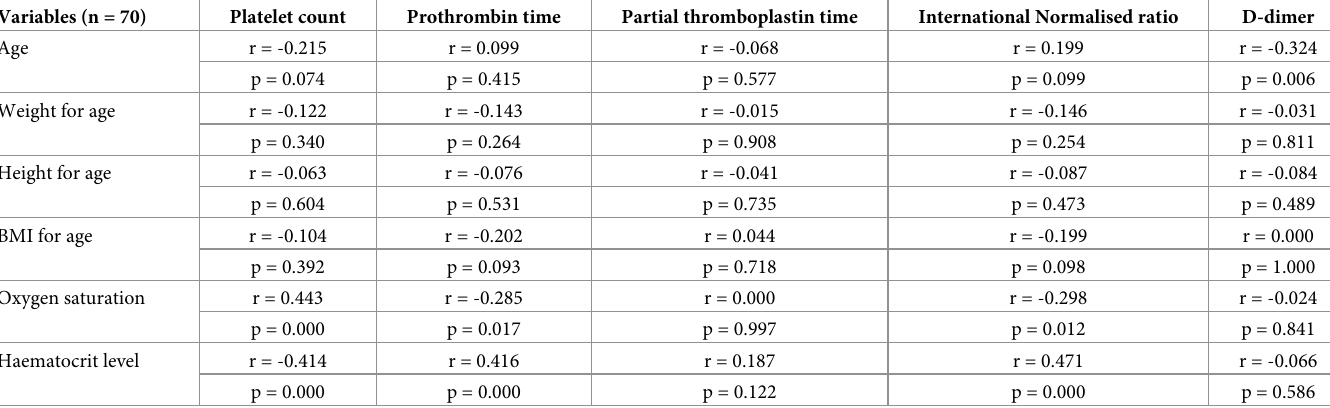
Table 10. Correlation between coagulation parameters and some independent